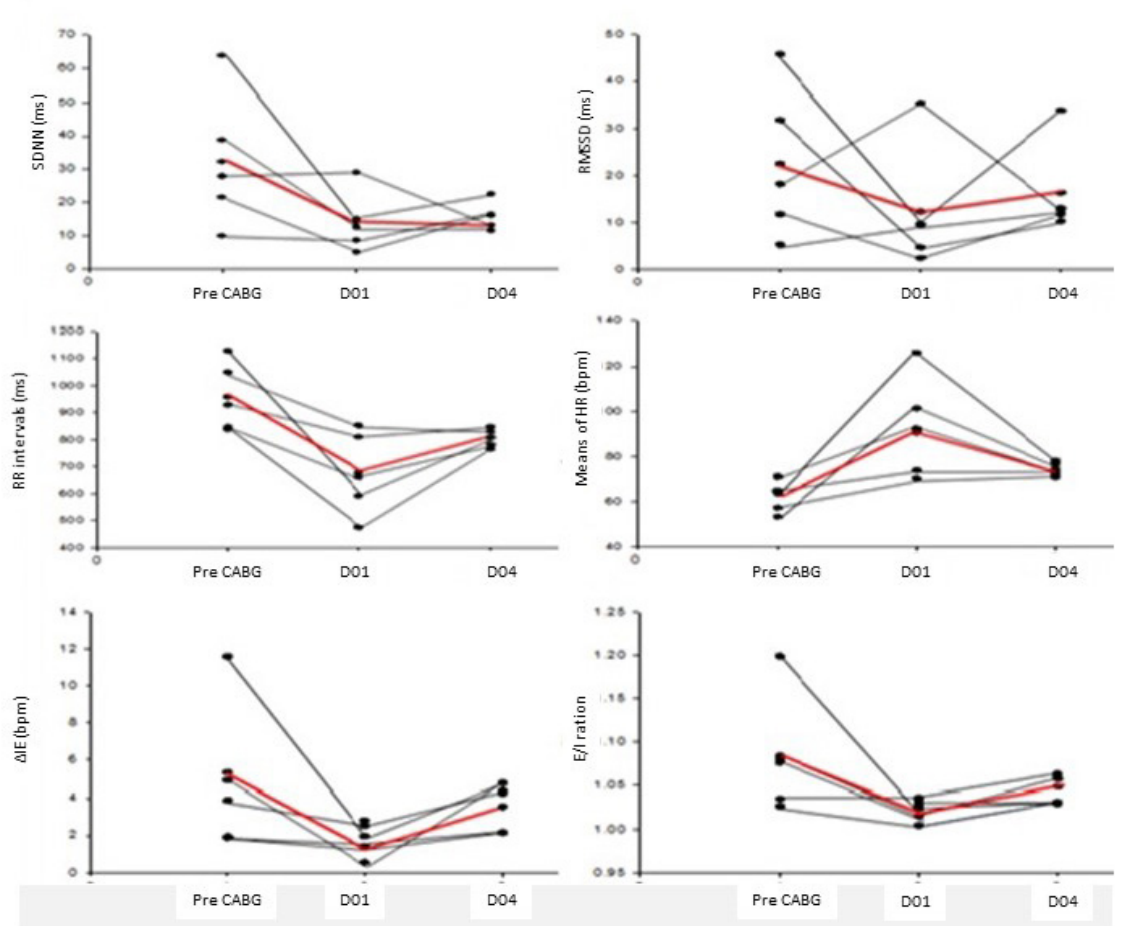
Fig. 1 - Heart rate variability and maneuver of respiratory sinus arrhythmia pre- and post-CABG. HRV and amplitude of RSA values during M-RSA of the five volunteers. Mean; Patient. ΔIE=difference between the mean of the highest HR values obtained during the inspiratory phase and the mean of the lowest HR values during the expiratory phase of M-RSA; D01=1st postoperative day; D04=4th postoperative day; E/I ratio=mean of the highest RRi values obtained during the expiratory phase divided by the means of the lowest RRi values of the inspiratory phase of the M-RSA; HR=heart rate; HRV=heart rate variability; M-RSA=maneuver of accentuation of respiratory sinus arrhythmia; RMSSD=square root of the mean square of successive differences between adjacent RRi divided by the number of RRi minus one in ms; RRi=R-R intervals; SDNN=standard deviation of all RRi in